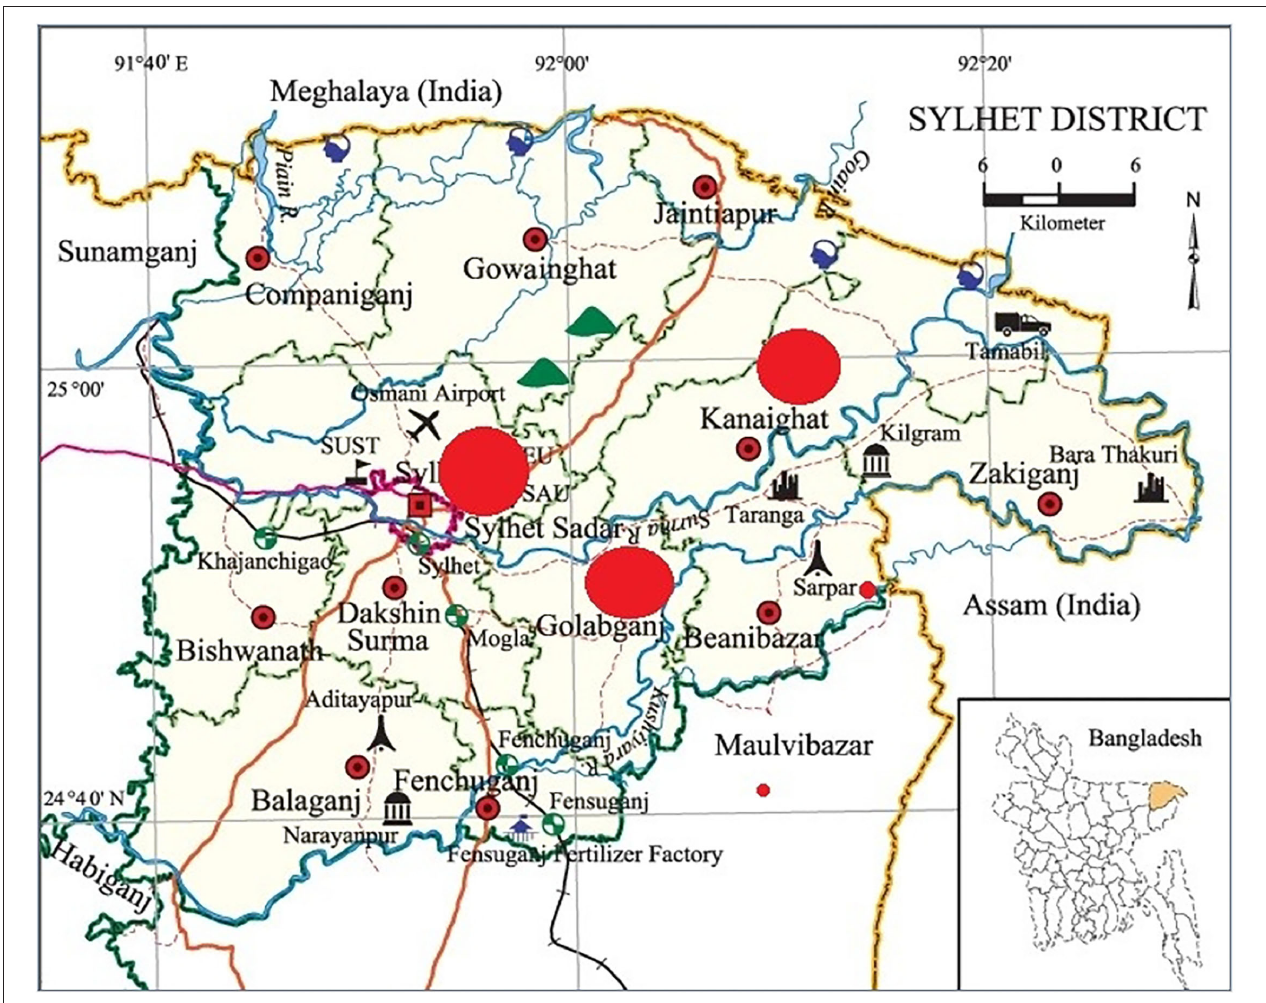
FIGURE 2 | Map of the study